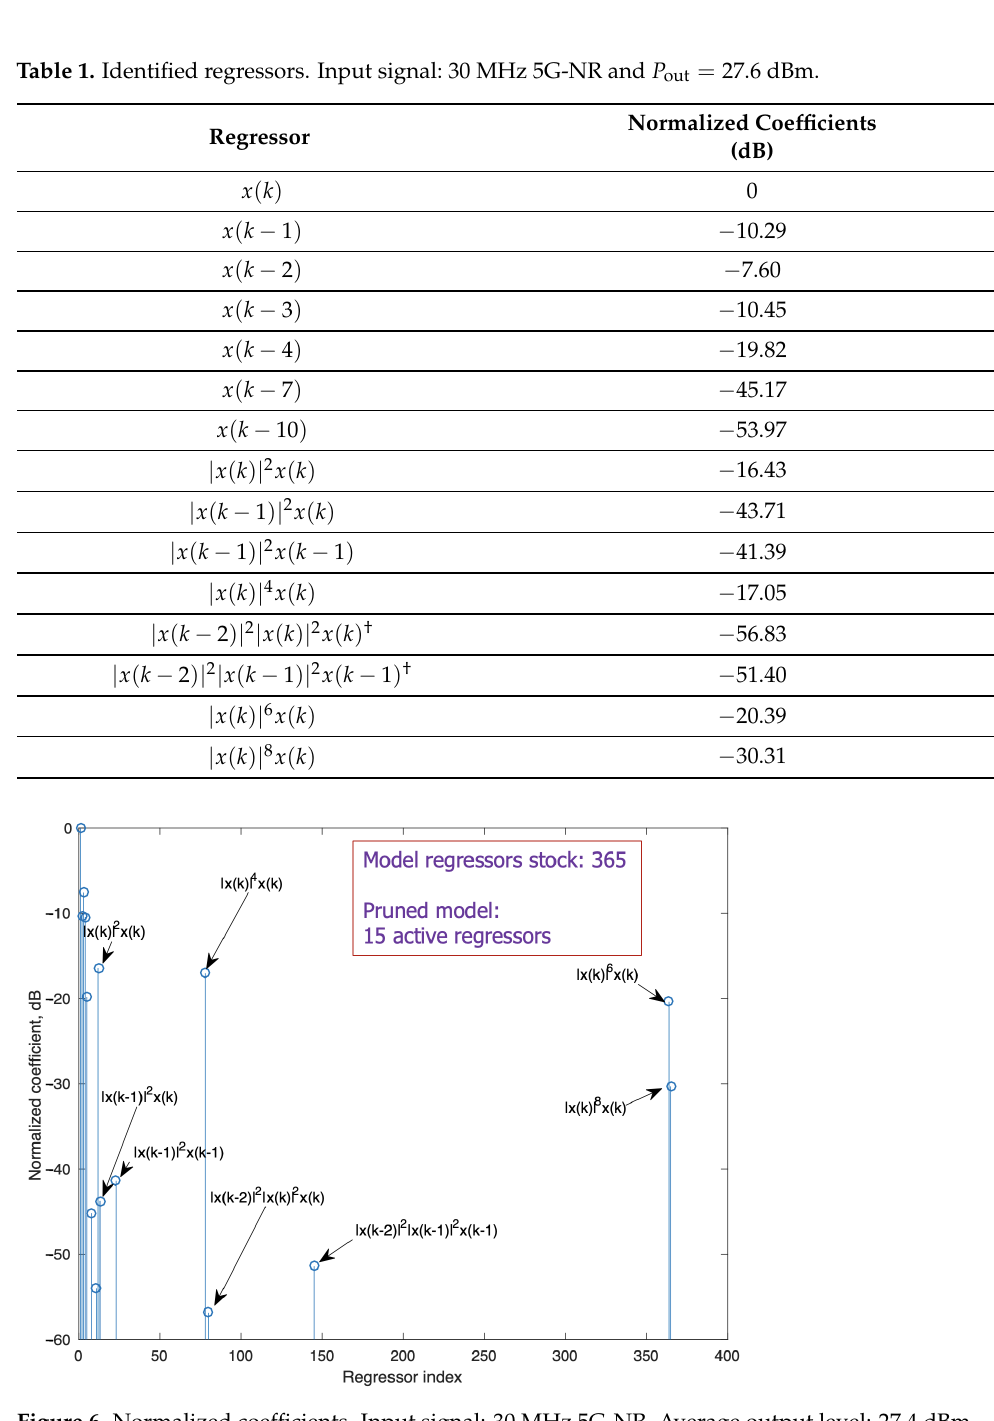
Figure 6. Normalized coefficients. Input signal: 30 MHz 5G-NR. Average output level: 27.4